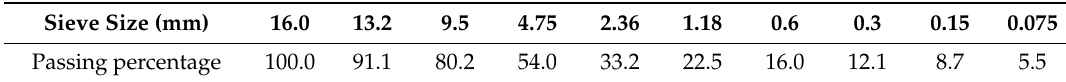
Table 2. Aggregate